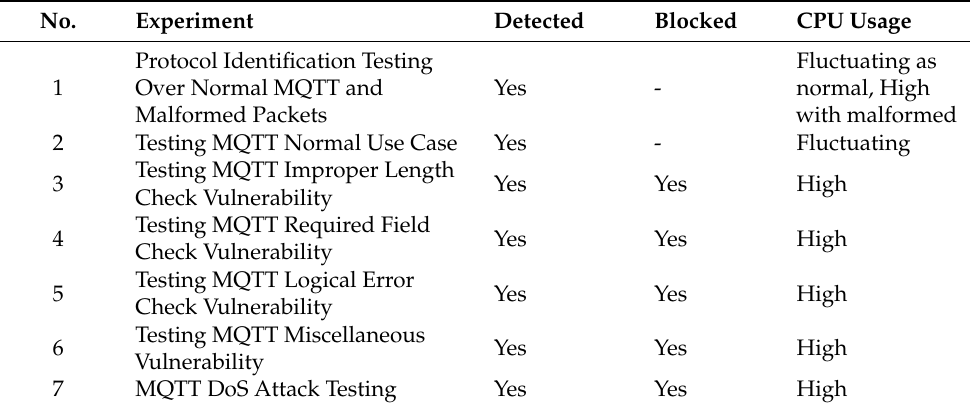
Table 3. Experimentation and results